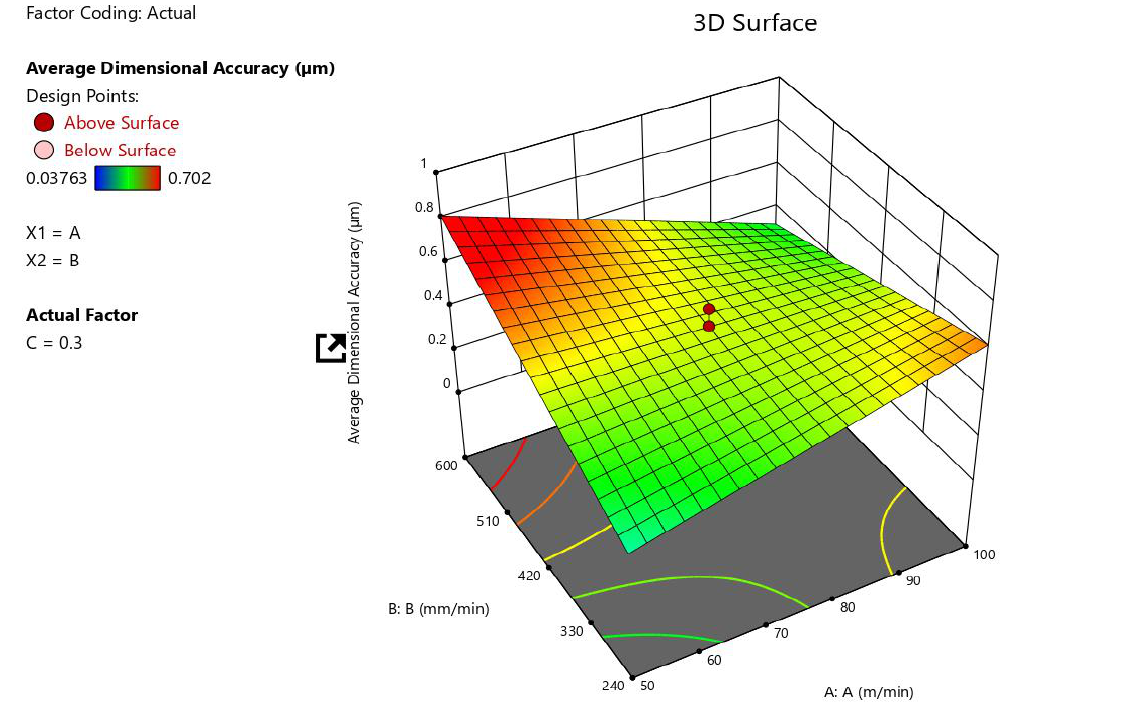
Figure 5. Effect of cutting speed (A) vs. feed rate (B). (Response as a function of cutting speed (A) and feed rate (B) for '0.3' level value of depth of cut (C) during the experimental